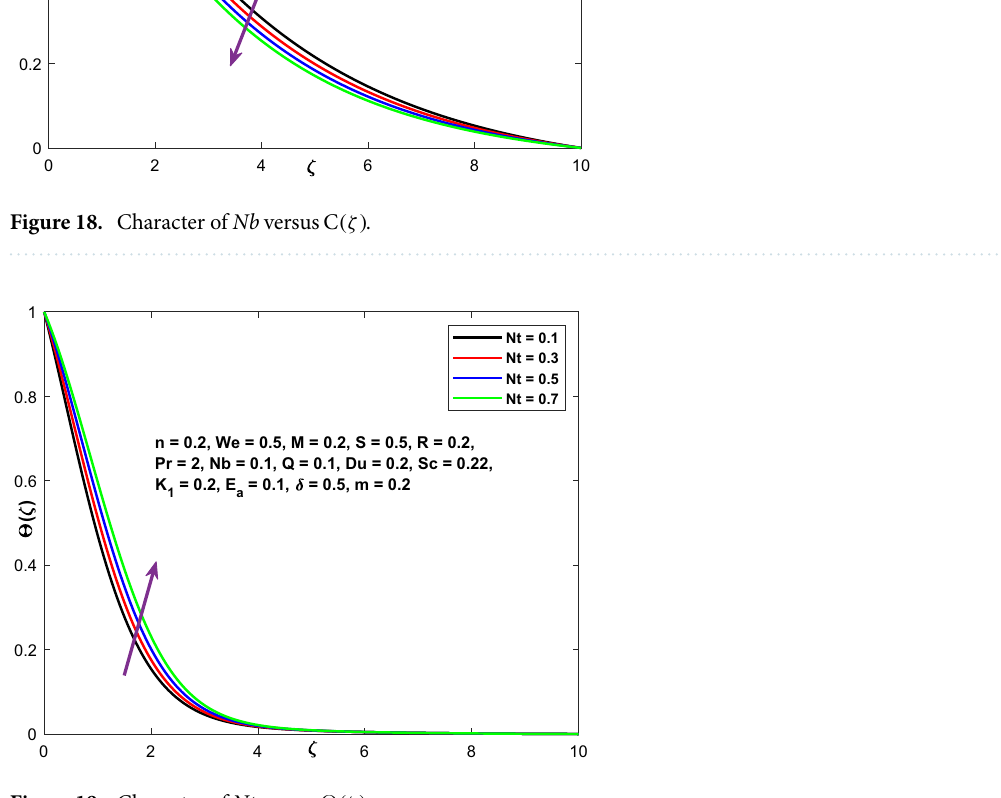
Figure 19. Character of Nt versus �(ζ) .